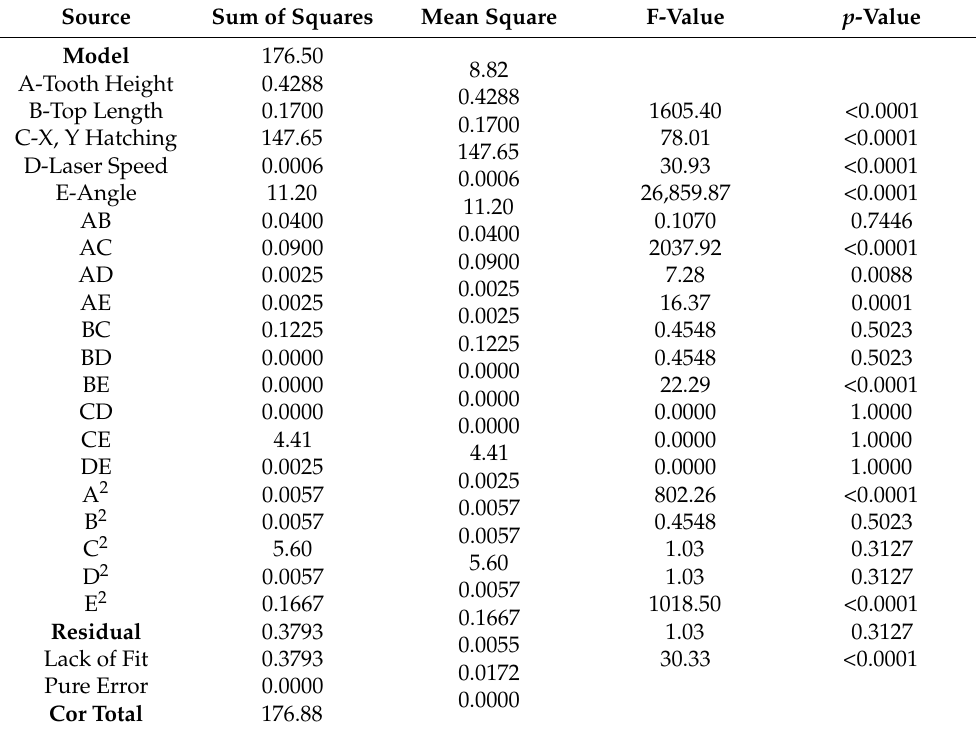
Table 4. ANOVA results for the quadratic model of Support